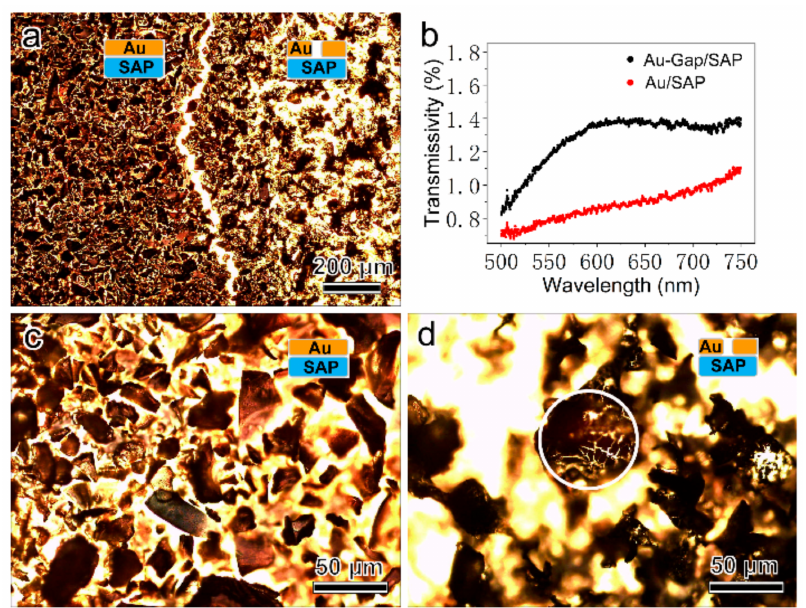
Figure 3. ( a ) Optical photograph of the Au/SAP structures (left side) and the Au-Gap/SAP structures (right side). ( b ) Visible transmission spectrum of the Au/SAP structures (red) and the Au-Gap/SAP structures (black). ( c ) Optical photograph of the Au/SAP structures. ( d ) Optical photograph of the Au-Gap/SAP structures (marked with the white circle).